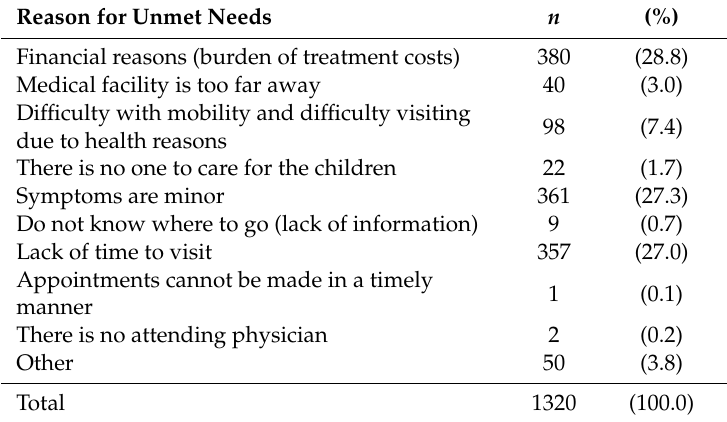
Table A2. Factors that a ff ect general perceived unmet